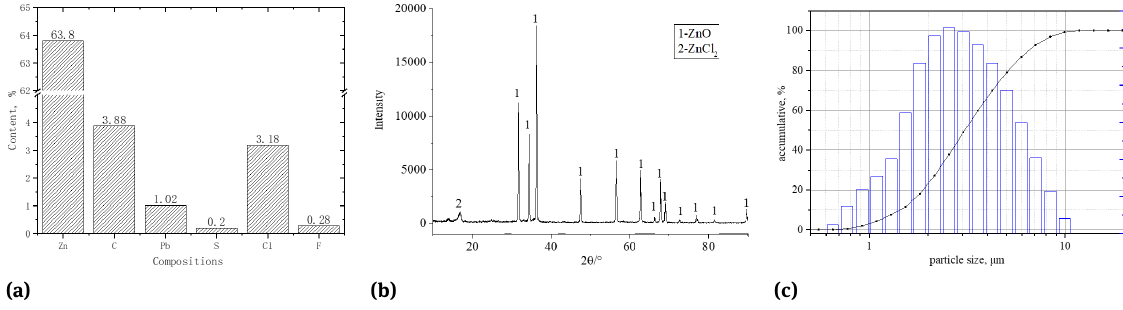
Figure 1: Physical and chemical properties of the steelmaking zinc-rich dust Table 1: Physical properties of ZnCl2 material phase transition